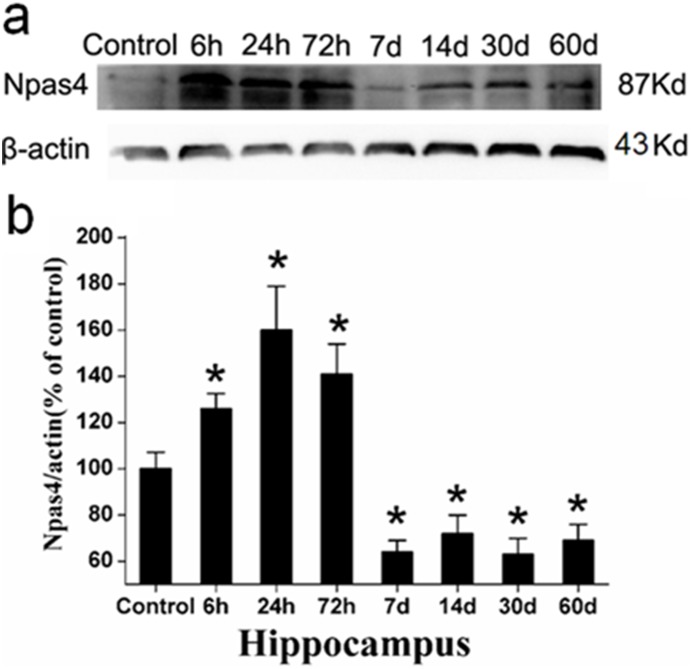
Western blot analysis of Npas4 expression in the hippocampi of pilocarpine-induced epilepsy rats.(a) Npas4 expression (band at 87 kDa) at different time points in the treatment and control rats. β-actin (band at 43 kDa) was used as a positive control. (b) Quantitative analysis of the mean OD ratio of Npas4 in the rat hippocampi. *P<0.05 was considered to indicate a significant difference between the controls and the different time-point groups.